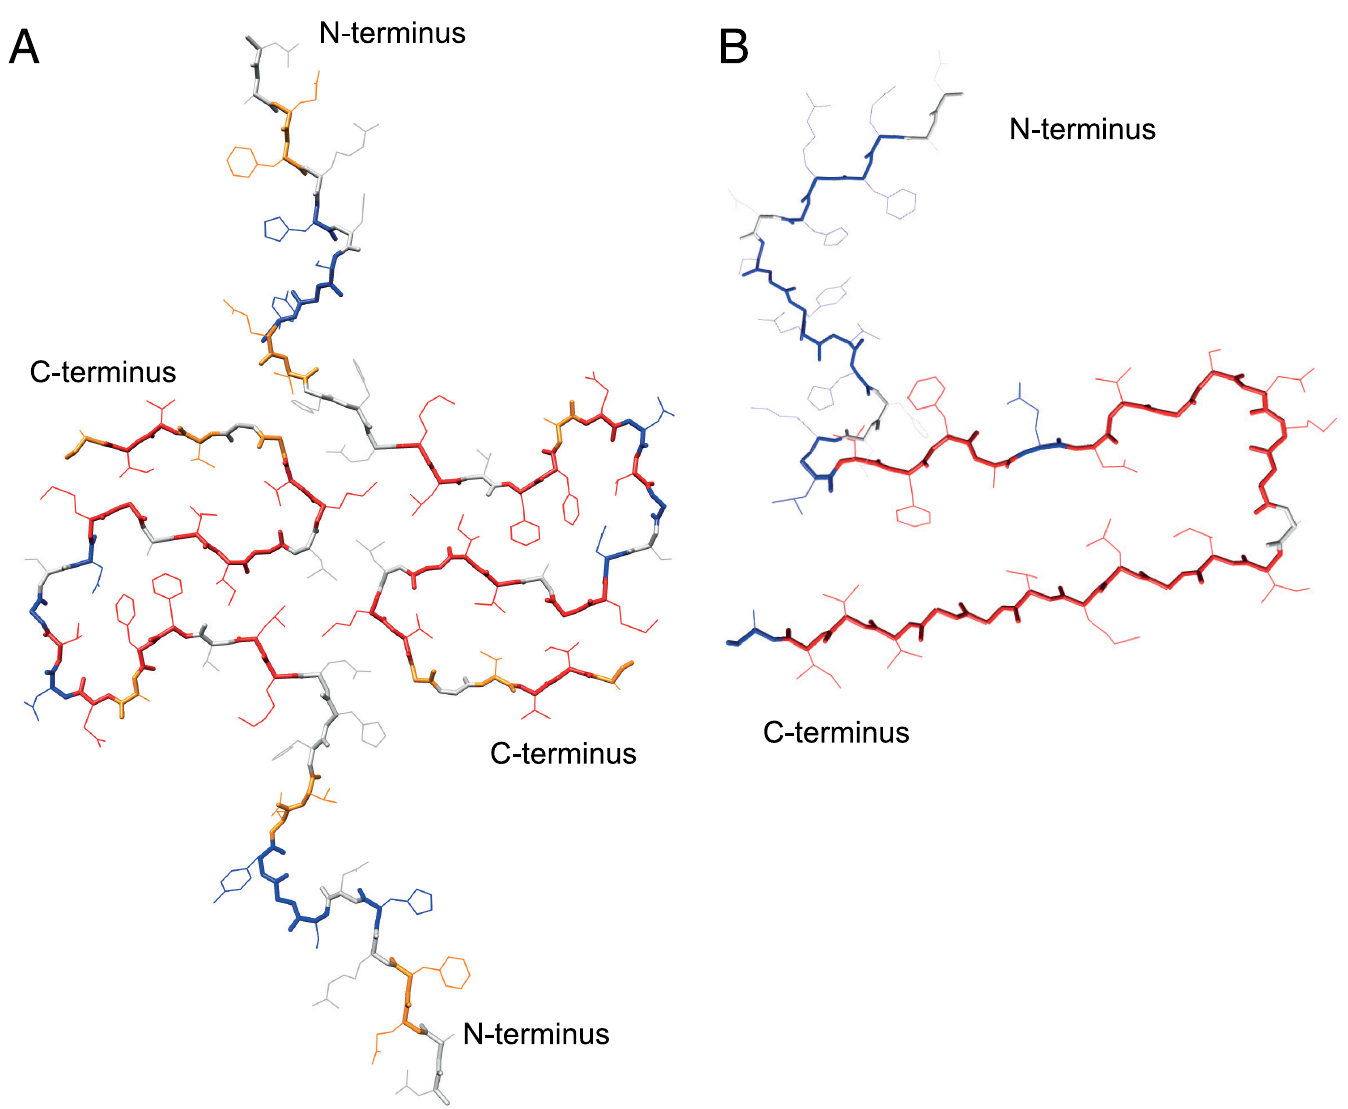
Fig 3. Quenched H/D exchange mapped onto the 3D structure of A β (1–42)fibrils. (A) The disease-relevant structure is composed of two moleculesper fibril layer [14] (pdb code 2NAO). The doublehorse shoe-likecore structure of the A β (1–42)fibrils shows the highest protection. (B) Structure of the polymorph by Lu¨hrs et al. [16] (pdb code 2beg). Solvent protectedresiduesare color coded in red, solvent exposedresiduesin blue, residues with 30–50% protection in orange, and residues lackingdata in white. residue K16 shows a bi-exponential decay with a fast as well as a slow exchanging component with similar populations. Based on this H/D exchange two extended β -sheets from L17-N27 and from I31-A42 were suggested. While a similar structural heterogeneity for residues 1–15 is observed in the H/D exchange of the polymorph studied here, the first slow exchanging seg- ment starts already at K16 but extends only to residues D23, a slow exchanging V24 (being part of β -strand β 3), followed by fast exchanging residues G25 and N27 and the slow exchang- ing segment K28-I41 which is interrupted at G37 and V39. Overall, in contrast to the extended slow exchanging segments predicted as two long β -strands of the polymorph of Lu¨hrs et al., the polymorph by Wa¨lti et al. shows shorter hydrogen protected regions, which are in